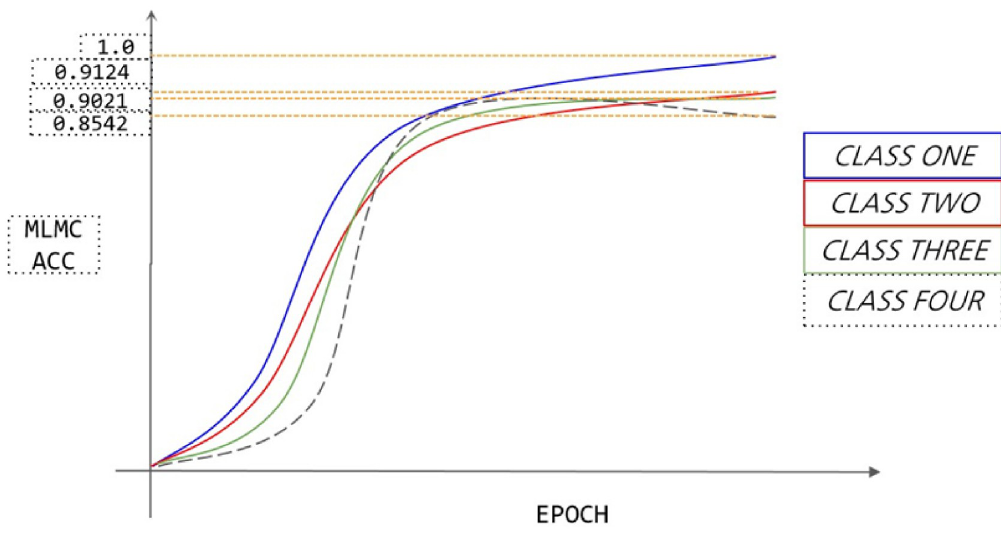
Fig 8. MLMC features in four types of data.